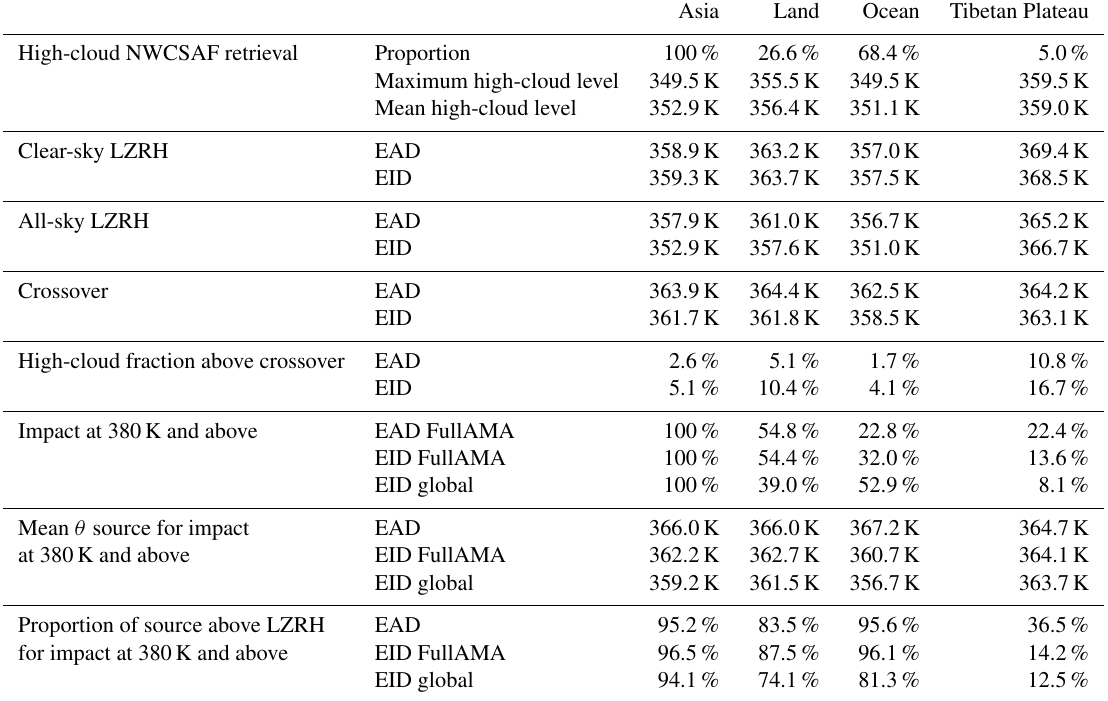
Table 1. Main characteristic numbers for the cloud distribution and the trajectories originating from Asia as a whole and its three subregions (Land, Ocean and Tibetan Plateau). When 100% is in the Asia column, the three other numbers in the row show the contributions of the three regions. EID is not separated into FullAMA and global cases when the distinction does not apply (LZRH and cloud fraction) or when it is negligible